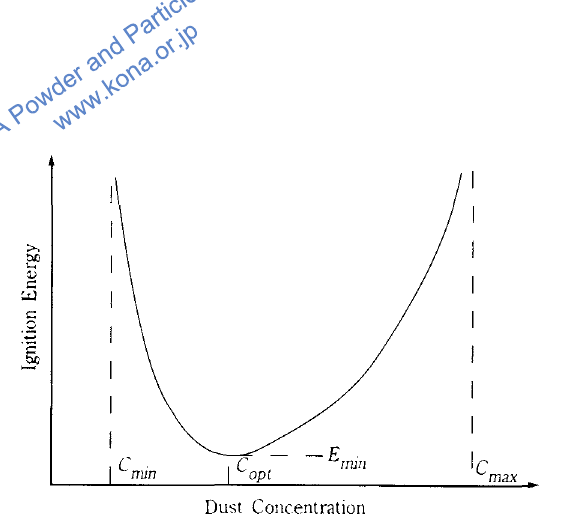
Fig. 3 Dependence of ignition energy on dust